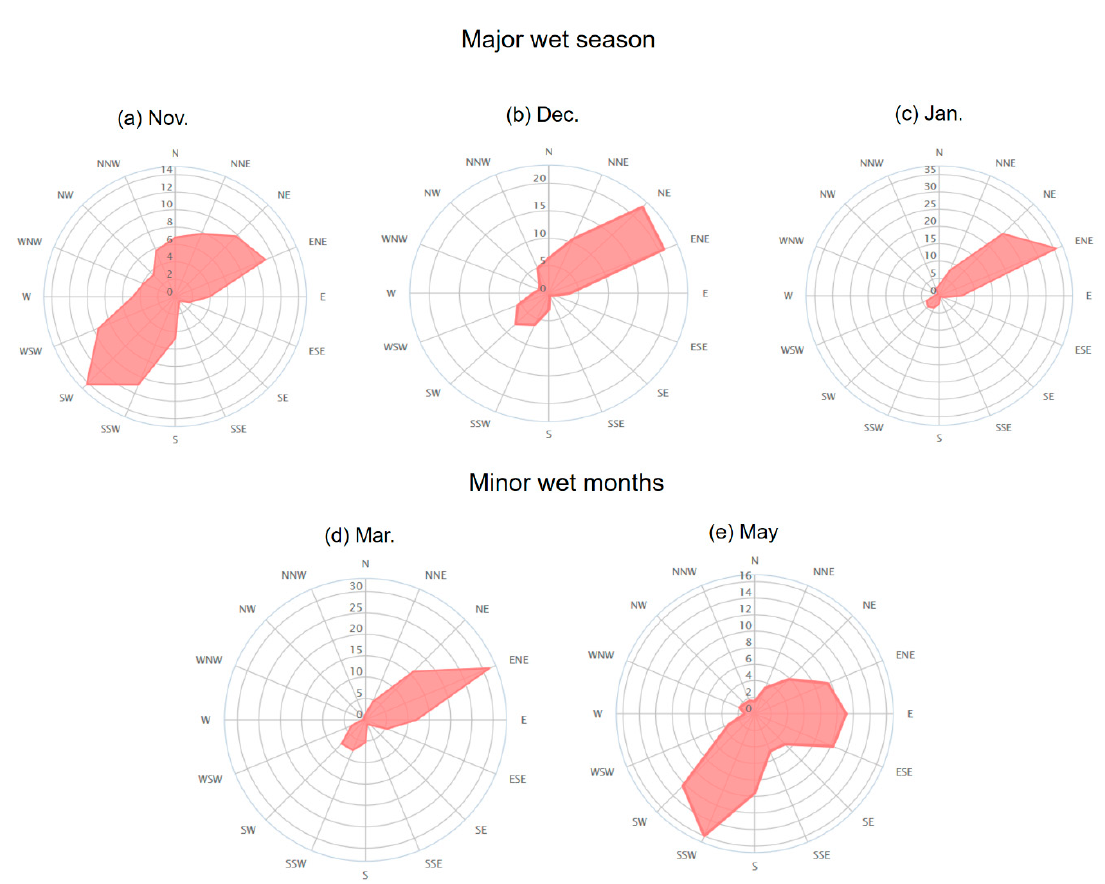
Figure 2. Rose wind vector during major wet season ( a ) November; ( b ) December; and ( c ) January and minor wet months ( d ) March; & ( e ) May.